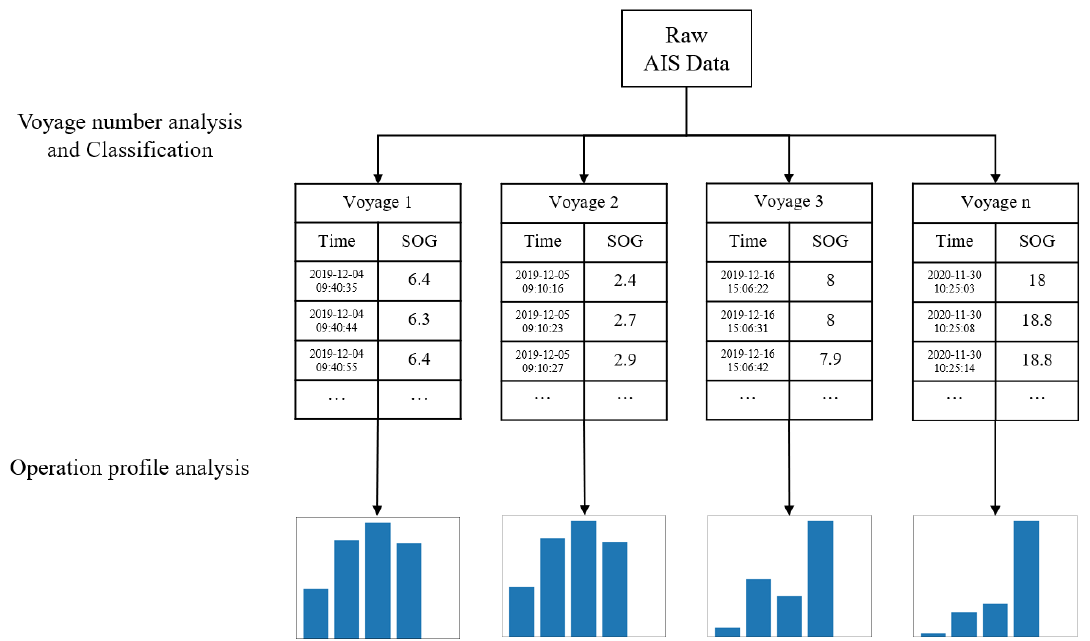
Figure 2. The data preprocessing procedure.